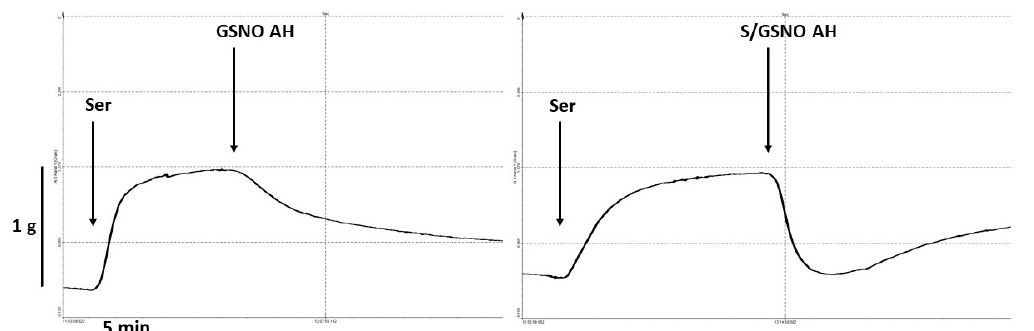
Figure 7. Original record of vasoactive responses induced by GSNO (0.5 µmol/L) and S/GSNO (0.5 µmol/L) products in serotonin (Ser, 1 µmol/L)-precontracted lobar artery of patient with arterial hypertension (AH).